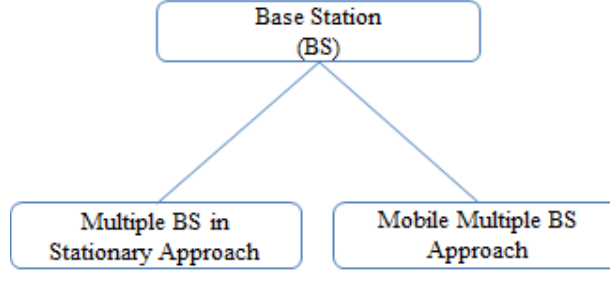
Figure 14. Sensing range and communication range of Sensor node